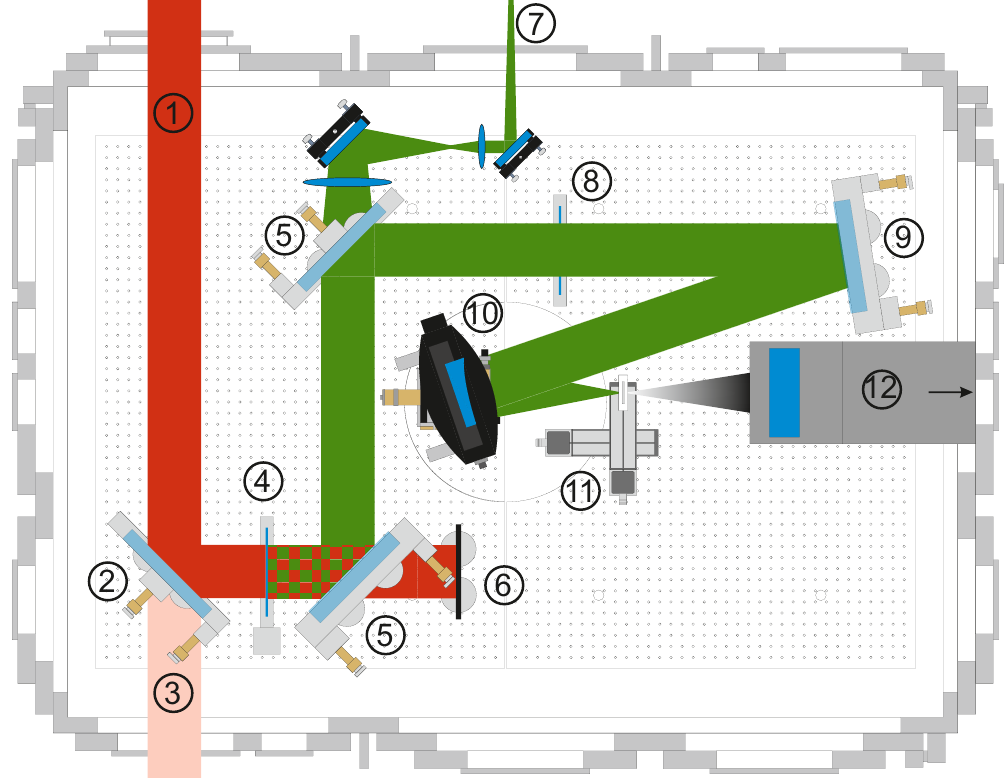
Figure 2. Schematic setup of the second harmonic generation and subsequent proton acceleration experiment in the POLARIS target chamber. 1 (cid:13) Input laser pulse. 2 (cid:13) Turning mirror. 3 (cid:13) Diagnostic leakage light. 4 (cid:13) KDP-crystal. 5 (cid:13) Wavelength separator. 6 (cid:13) Beam dump. 7 (cid:13) SHG focus diagnostic. 8 (cid:13) Quarter-wave plate. 9 (cid:13) Turning mirror. 10 (cid:13) (cid:13) parabola. 11 Target. 12 Proton